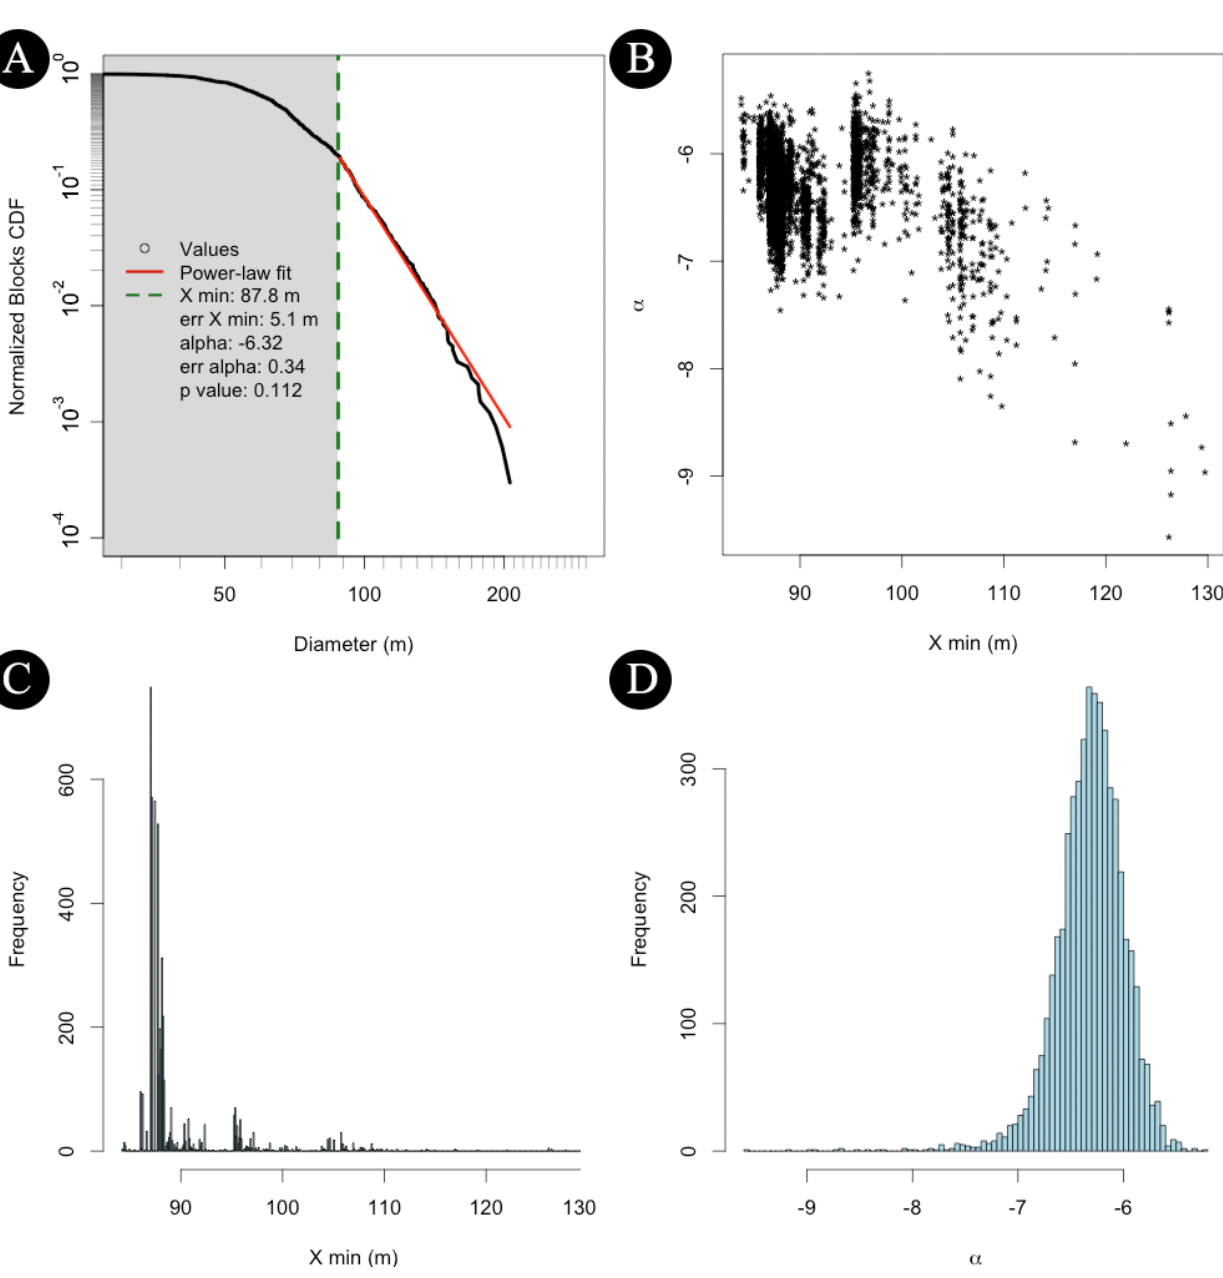
Figure 11. The Cairo case study. ( A ) Normalized cumulative distribution function showing the obtained sizes, the power- law fitting curve and the x min limit (the grey shadowed area is not considered by the fit). The total number of blocks larger than x min and used for the fit is 659. ( B ) Scatter-plot of x min against 𝛼 resulting from 5000 synthetic datasets. ( C ) Frequency histogram of x min . ( D ) Frequency histogram of the power-law index 𝛼 .